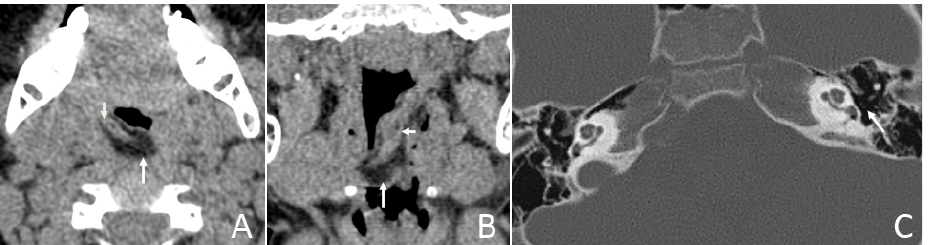
Figure 6. CT of a 2-year and 11-month boy presenting with snoring and mouth breathing for 3 months and hearing impairment found during physical examination. ( A , B ) Axial and coronal CT displayed in the soft-tissue window show the fat density mass (long arrow) originating from the back side of the left soft palate with a soft tissue density core (short arrow). ( C ) Axial CT, displayed in the bone window, shows the absence of the left stapes head and part of the stapes arch (arrow). None of the patients were associated with syndromic disorders.